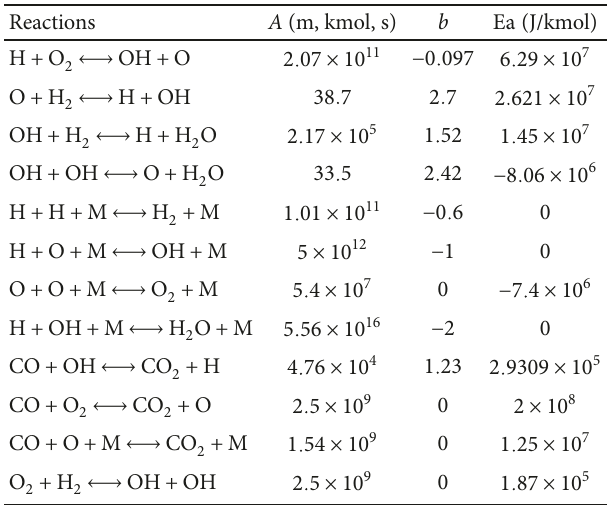
Table 1: RP-1/LOX plume fi nite-rate reactions.